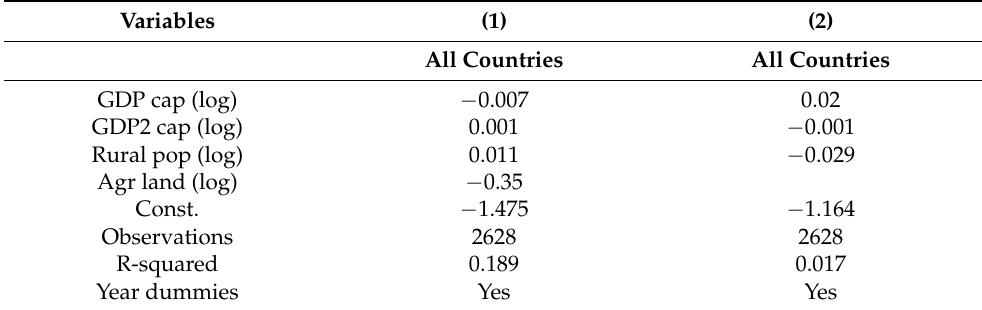
Table 8. Long-run equations, all